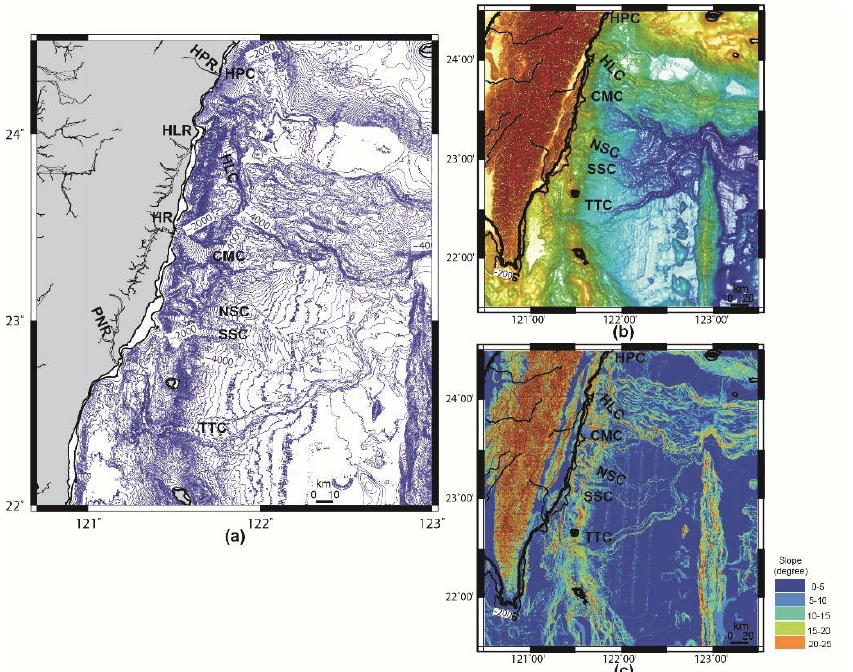
Figure 4. ( a ) River drainage and surrounding bathymetric contours of the East Taiwan margin. Note the outline of the 120 m depth contour off the shore of East Taiwan. ( b ) Shaded relief map of East Taiwan. ( c ) Slope gradient map of East Taiwan. Note that the slope gradient of the shelf along the East Taiwan margin is greater than 5 degrees. There are six major submarine canyons that stretch from north to south for a distance of 220 km along the narrow shelf off the eastern Taiwan coast.